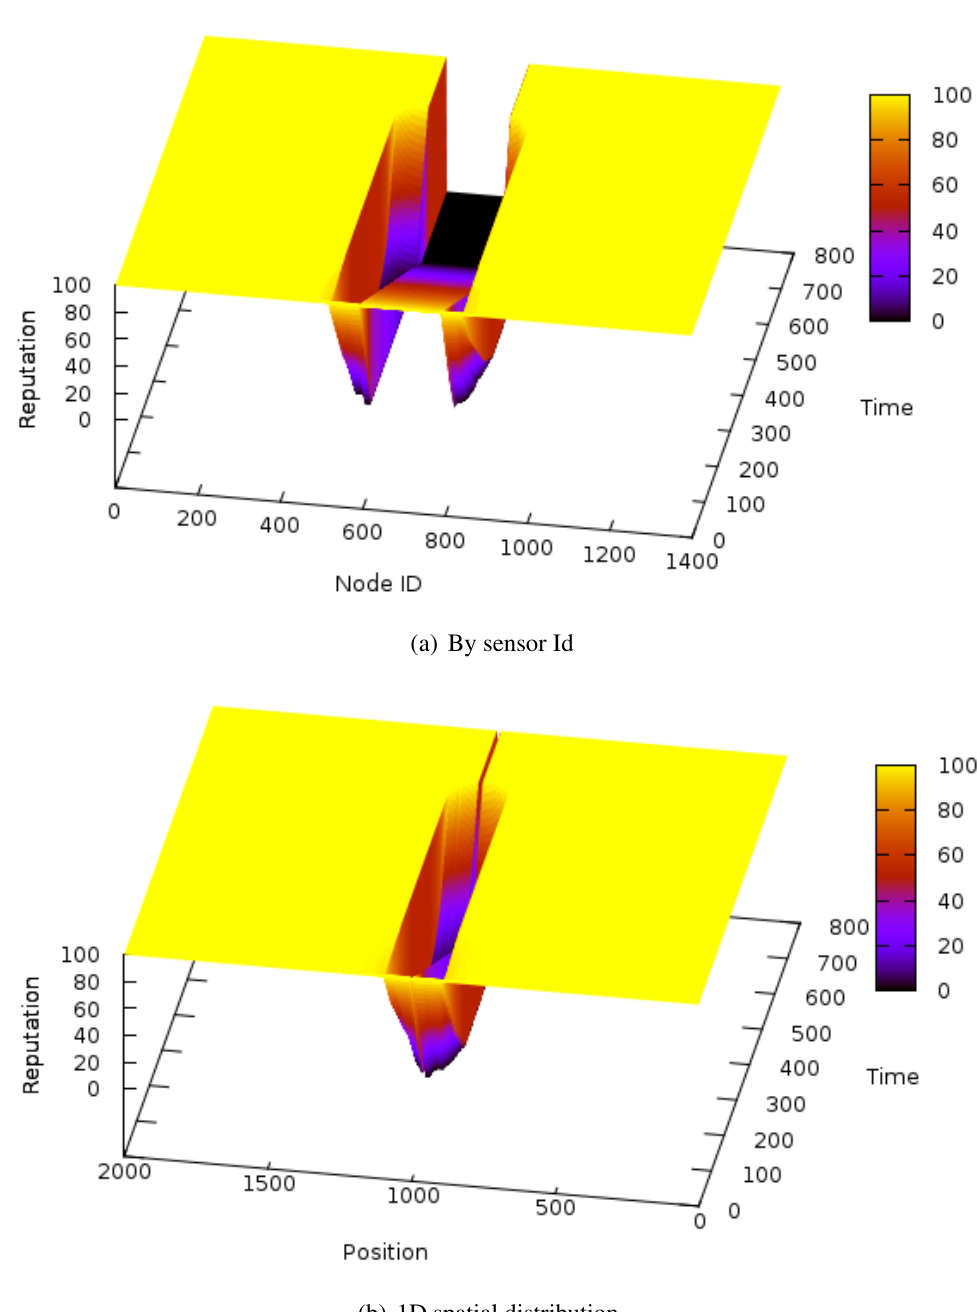
Figure 3. Reputation evolution for a sybil